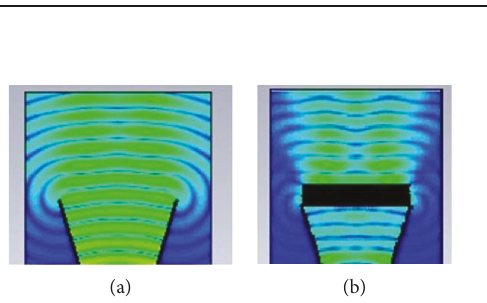
Figure 11: Spherical to plane wave transformation (a) without the structure (b) with the